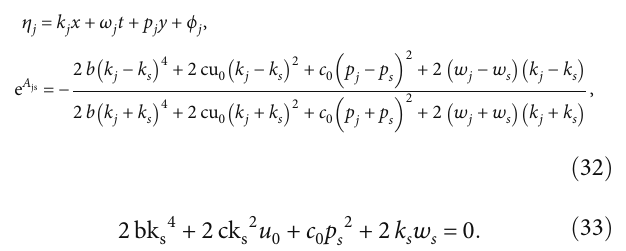
Figure 3: Two types of second-order breather solutions in Equation (1) with parameters c k 3 = − 3/5 i , k 4 = 3/5 i , p 3 = − 1 , p 4 = − 1 , ϕ 1 = 0 , ϕ 2 = 0 , ϕ 3 = 0 , and ϕ 4 = 0 at t = 0 . (a) Bright-type breather with u 0 = 1 and c = − 1 . (b) Dark- type breather with u 0 = − 1 and c = 1